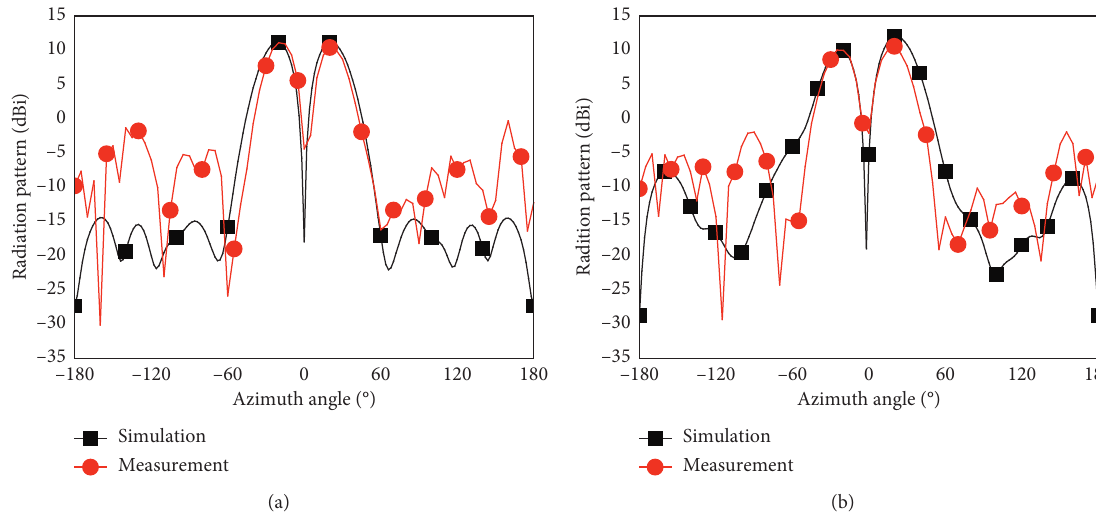
Figure 18: Comparison of the radiation pattern (prototype). (a) Antenna arrays without SRRs. (b) Antenna arrays with